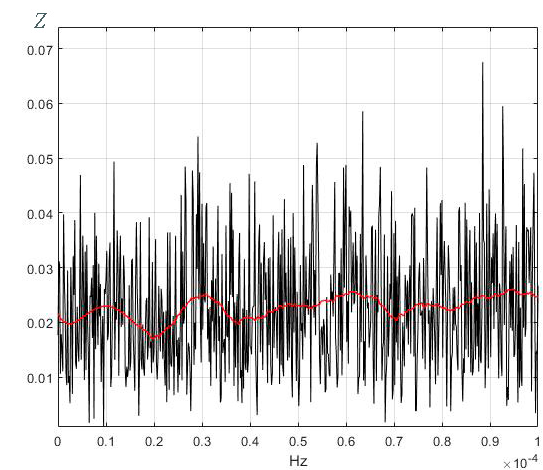
Figure 10. Fourier series plot for random signal (white noise). Black line: Fourier series; red lines: Savitzky-Golay filter.